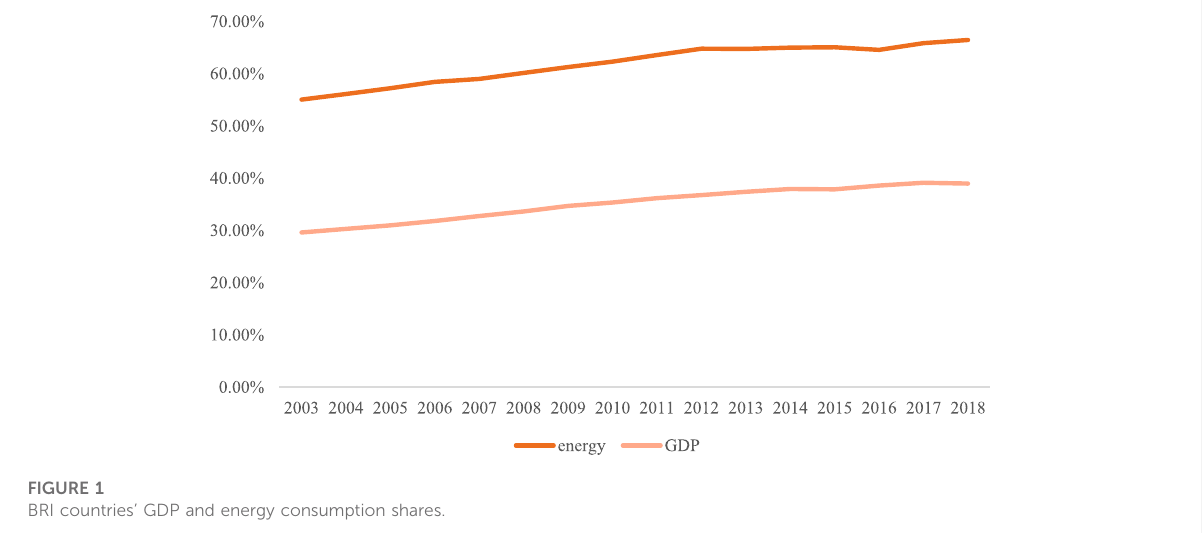
FIGURE 1 BRI countries ’ GDP and energy consumption